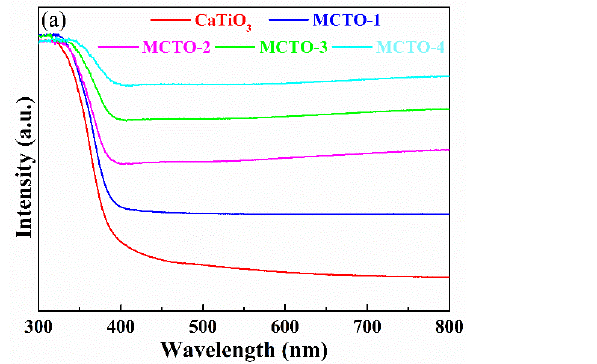
Figure 5. UV – Vis absorption spectra ( a ) and ( αhν ) 2 plots ( b ) of the different MoS 2 /CaTiO 3 .